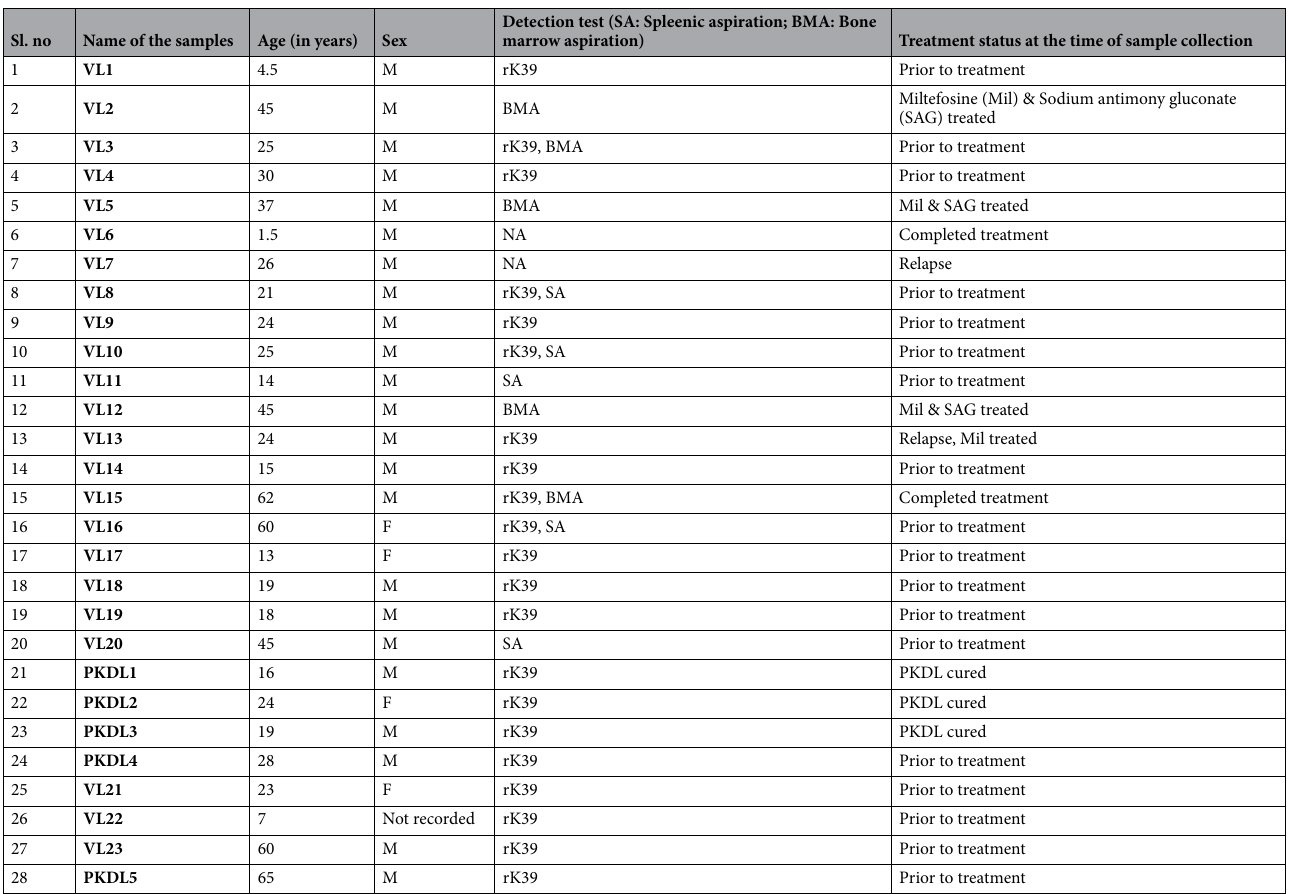
Table 4. List of the serum samples along with the patient